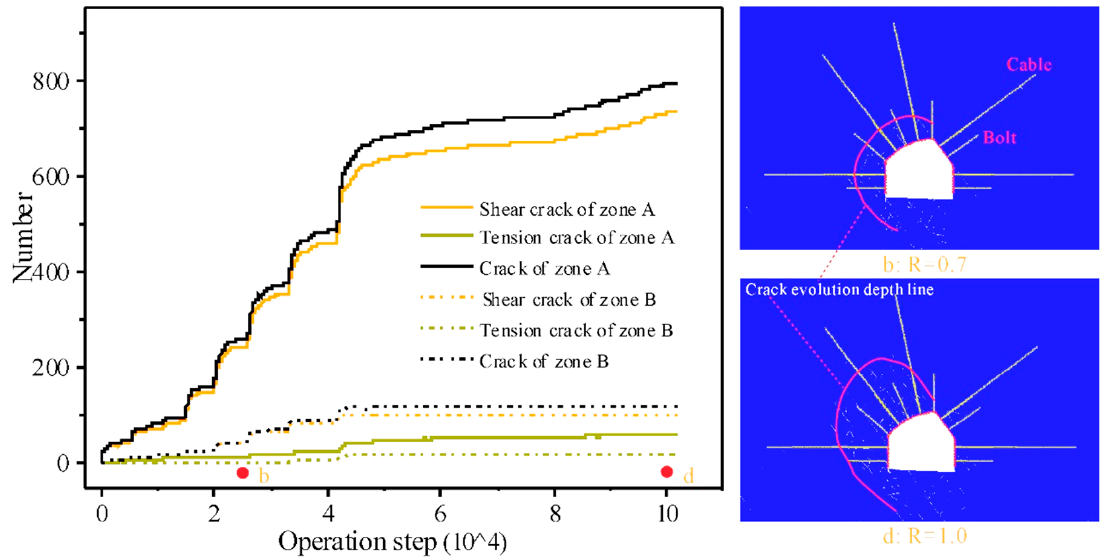
Figure 11. Evolution characteristics of cracks in the surrounding rocks under the primary support.